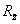
Graft surface roughness and representative measurements.A) The box plots show the differences of the mean roughness indices (Rz~, μm) between the different graft surfaces. The statistical significances between the different grafts were as follows: p<0.0001 for PET versus OIS, PAD and SAC; ePTFE versus OIS and SAC; OIS versus INV and STD; p = 0.0002 for INV versus SAC; PAD versus SAC, SAC versus STD and INV versus PAD, p = 0.0028 for PET versus ePTFE, p = 0.0173 for PET versus STD; p = 0.0292 for ePTFE versus INV and p = 0.0156 for OIS versus PAD. The lower, mid and upper horizontal lines of the boxes represent 25th, 50th and 75th percentiles, respectively; the vertical lines extend from the 10th to the 90th percentile. B) Image shows the calculation for Rz~ on the resliced CLSM stack for STD graft. The red line indicates the surface depth measured for each sub-division of the image. *p<0.05, **p<0.01, ***p<0.0001.